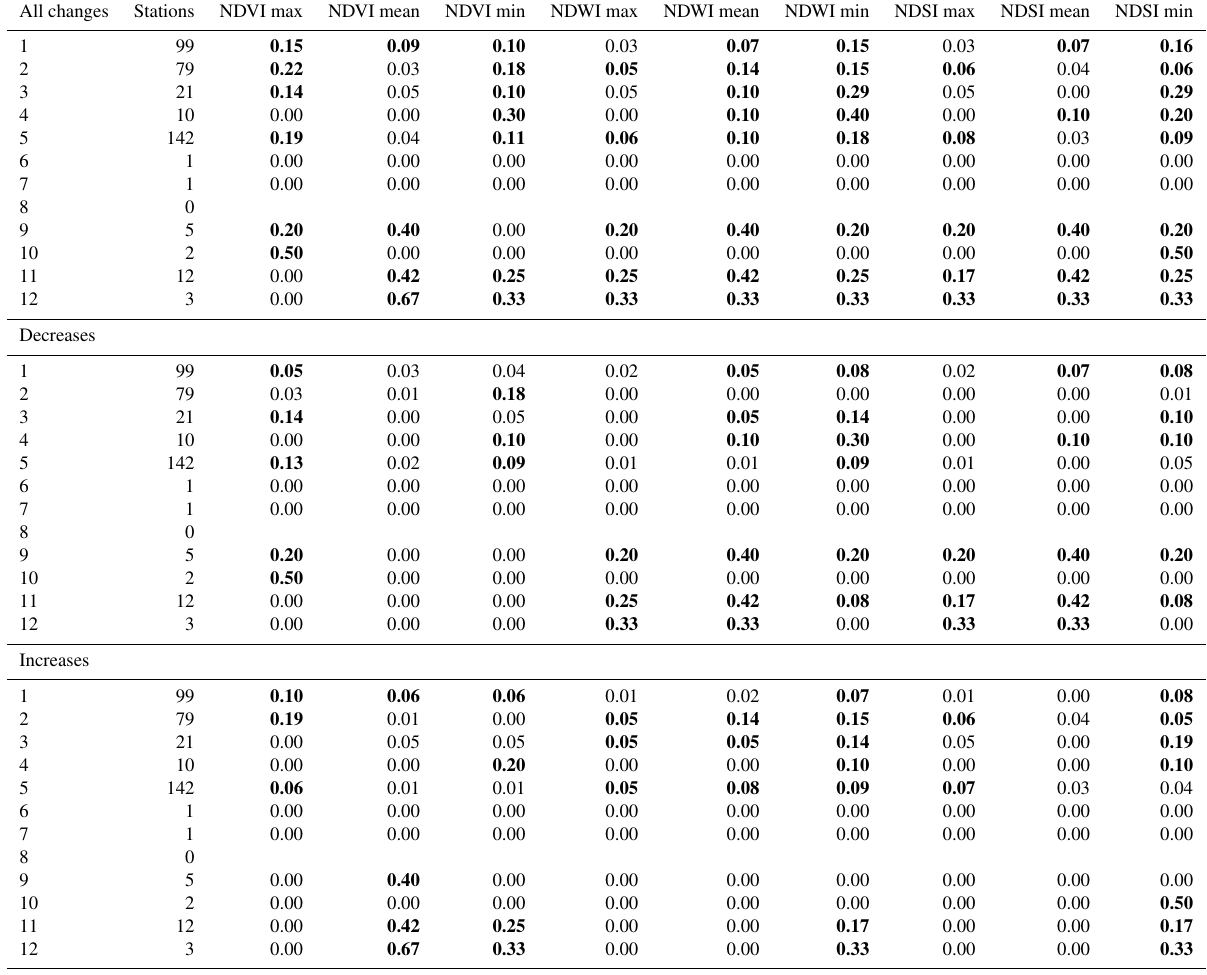
Table 7. Trends in satellite indices in relation to Streamflow Regime Type. The numbers are the fraction of stations showing a trend; values greater than 0.05 are in